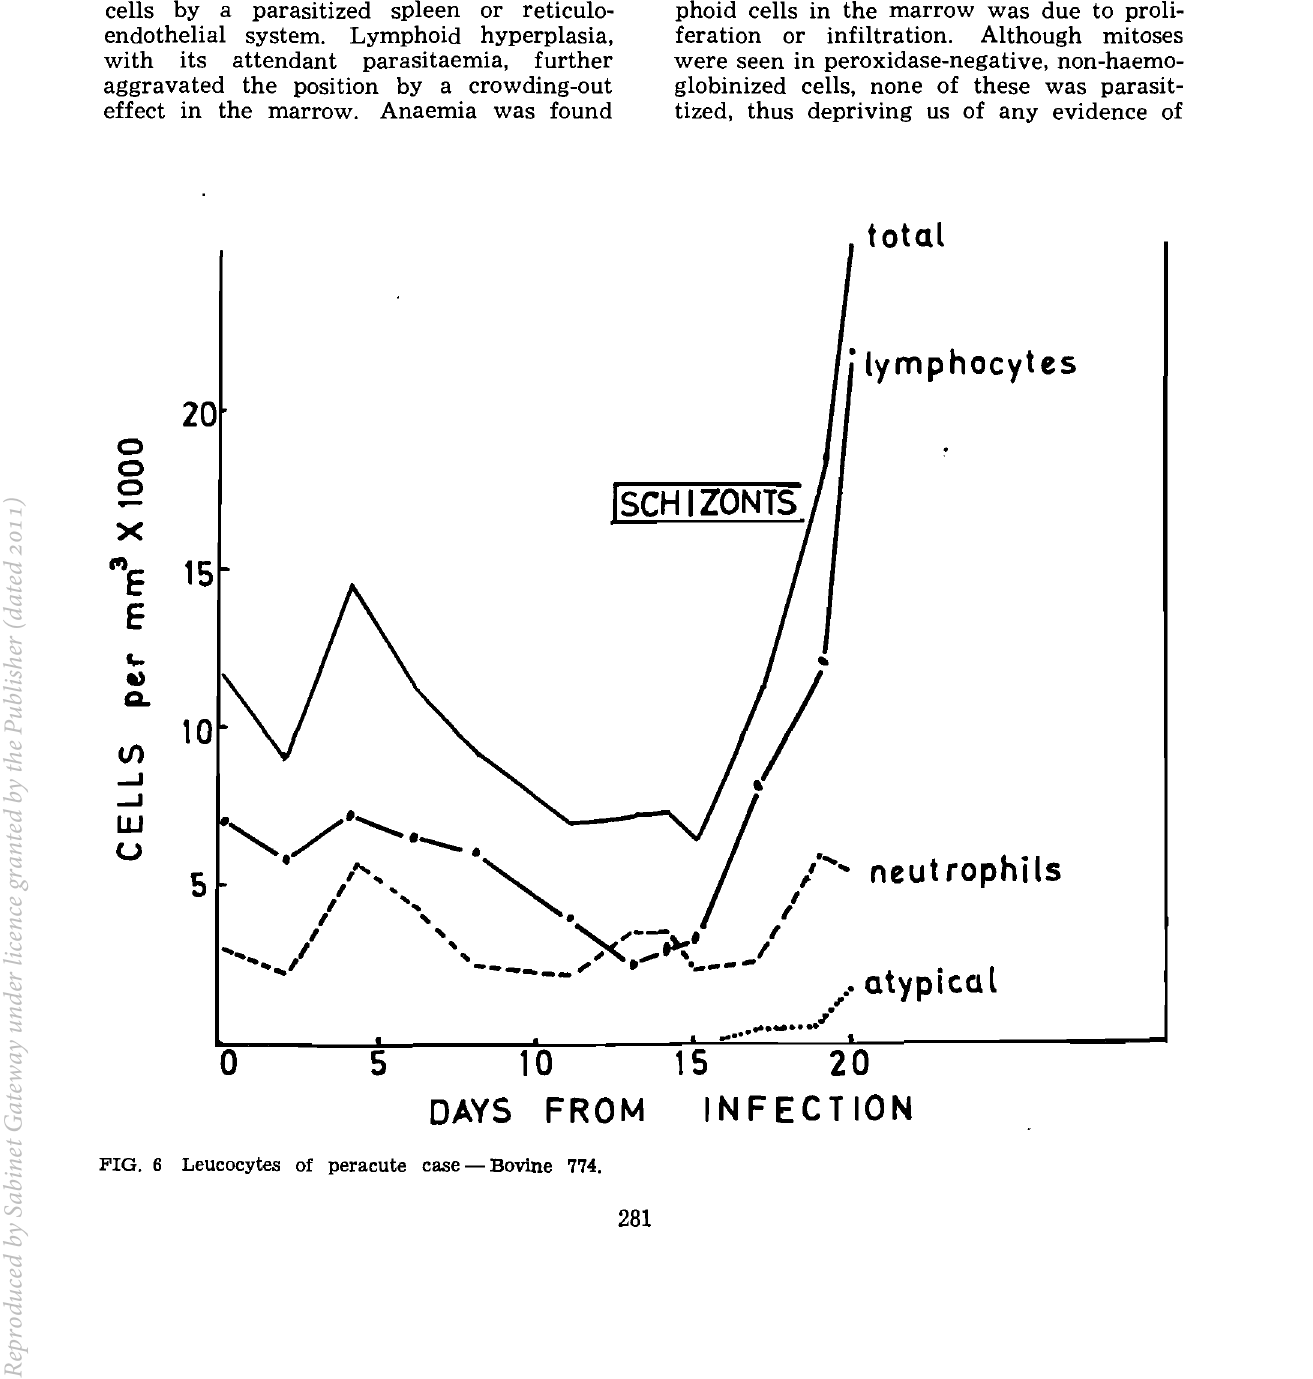
FIG. 6 Leucocytes of peracute case - Bovine